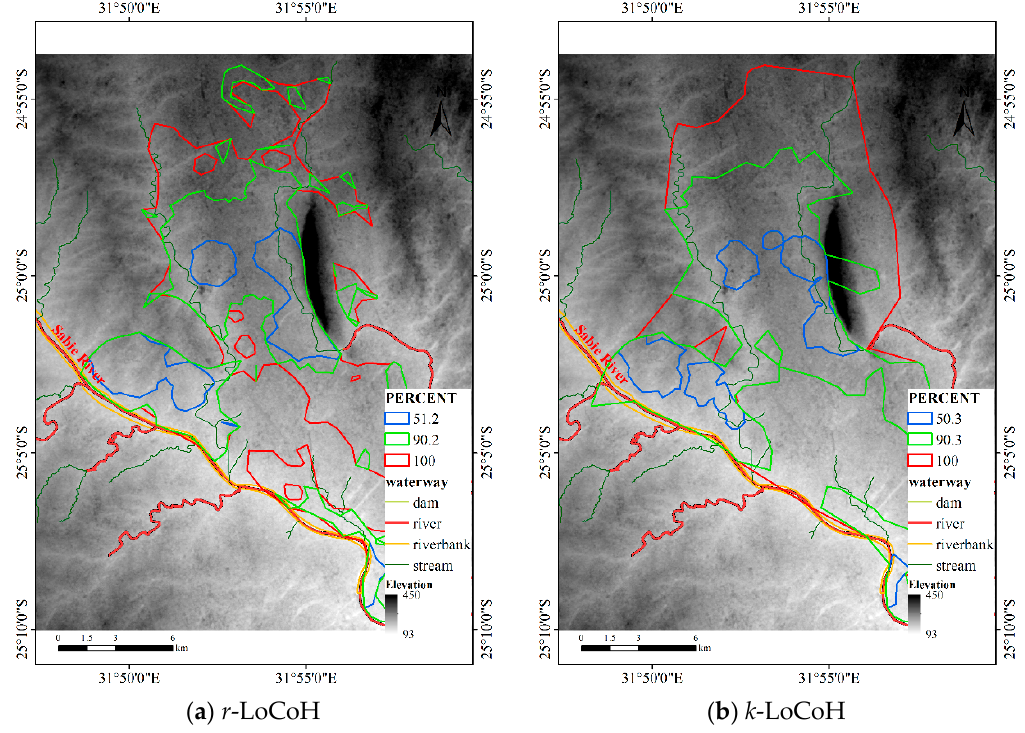
Figure 18. HRs of the LoCoH method for Dataset 3.